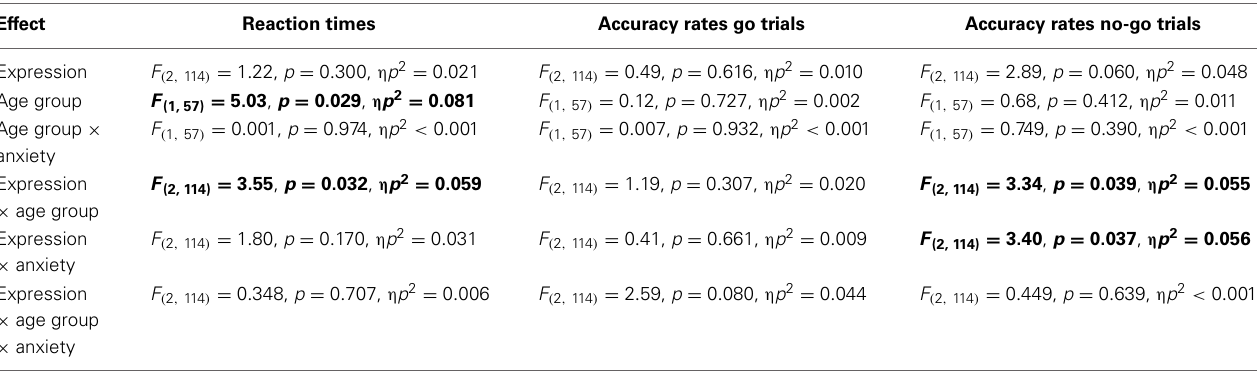
Bold font indicates significant